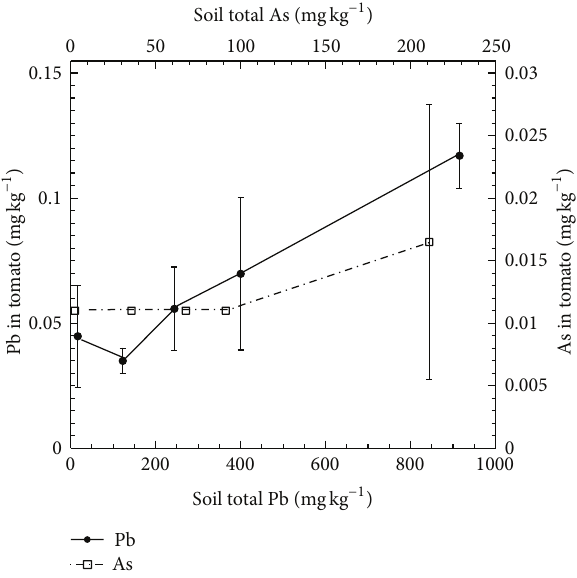
Figure 5: Pb and As concentrations (mgkg −1 d.w.) in tomato fruit grown on orchard soils containing a range of Pb and